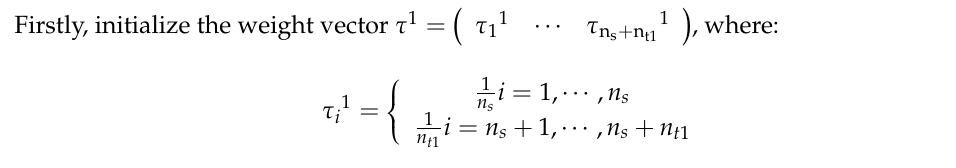
Figure 1. Schematic diagram of the proposed process monitoring framework.